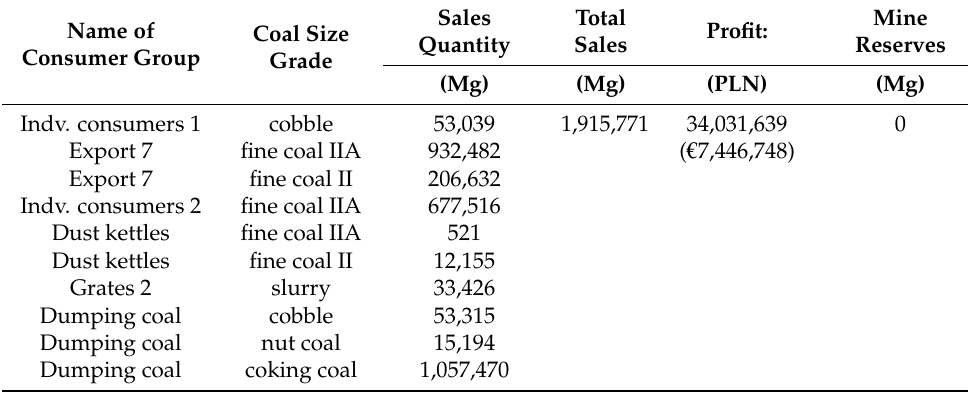
Table A9. The optimal production and sales plan for mine “G” for